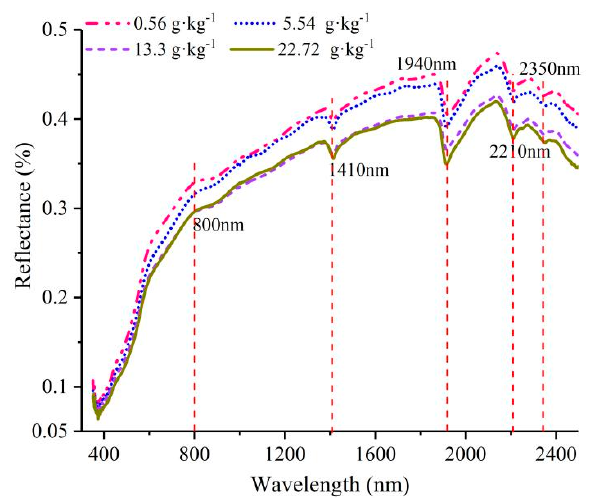
Figure 4. Average reflectance of soil with different SSCs.